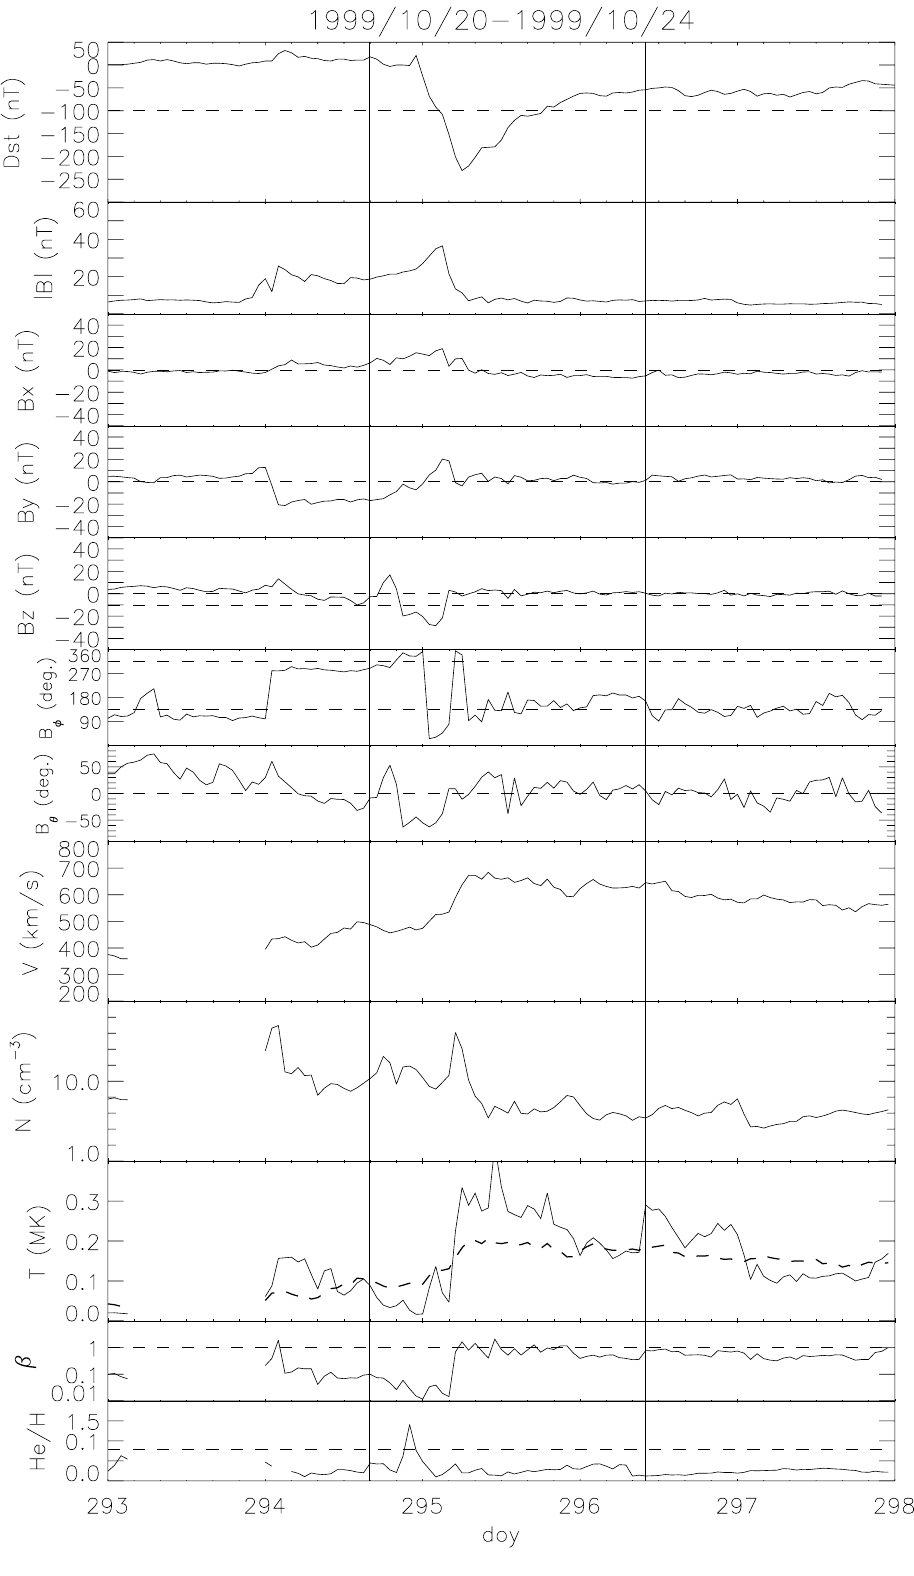
Fig. 4. D st index and solar wind parameters of storm no. 16. Two vertical solid lines show the duration of the geomagnetic